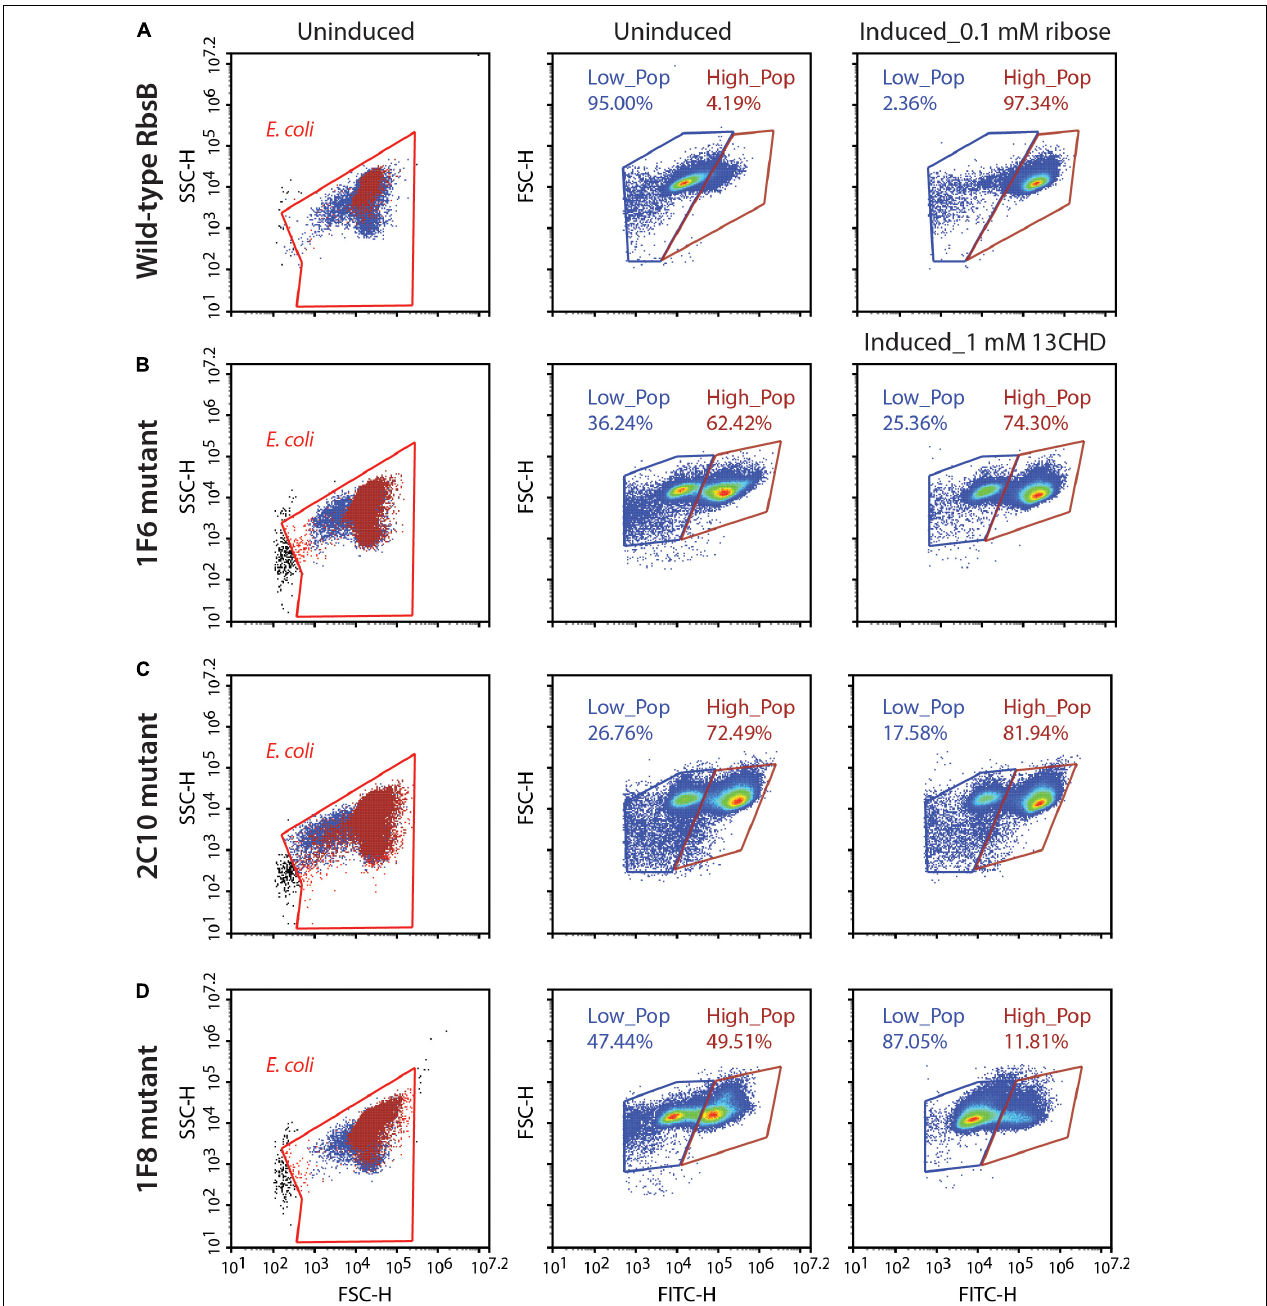
FIGURE 2 | DT038-derivative mutants displaying subpopulations with two fluorescence states. Low_Pop and High_Pop represents cells with low and high fluorescence levels, respectively. Proportions of cells within both gates are indicated. (A) Wild-type RbsB uninduced and induced with 0.1 mM. (B–D) As (A) , but for mutant 1F6, 2C10, and 1F8 induced with 1 mM 13CHD. Each density plot shows 100,000